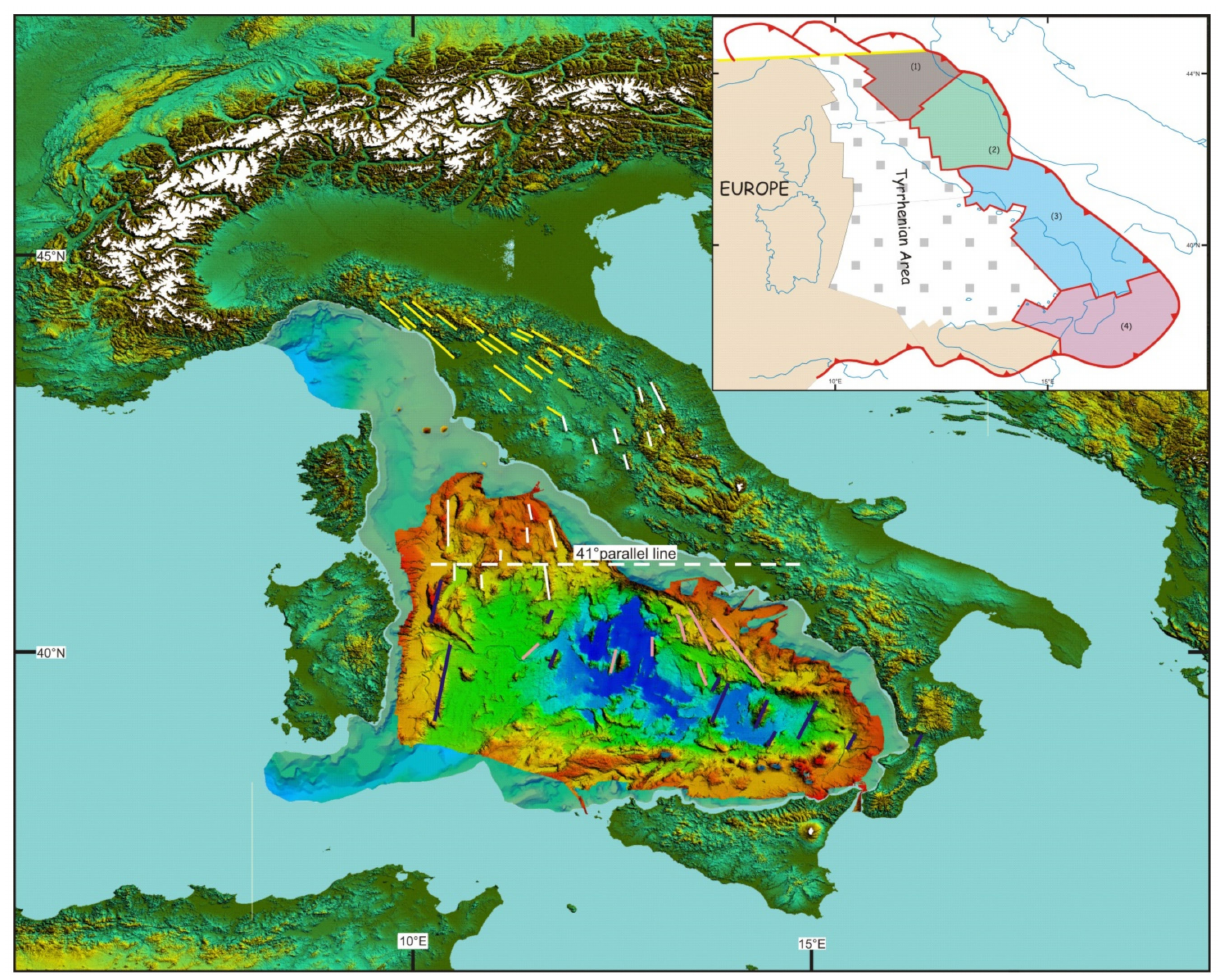
Figure 9. Morpho-tectonic map of the Tyrrhenian–Apennine system showing lineaments that can be grouped into fan- shaped sets characterizing specific sectors. Lineaments of the Northern Apennine sector are in ( yellow ; white lines ) are for northern Tyrrhenian basin and Central Apennine sector; ( blue and pink lines ) are for Calabrian and Southern sectors respectively. The multibeam bathymetry is after [63]. The insert box shows the deformable blocks identified: (1) Northern sector in ( dark beige ), (2) Central Sector in ( green ), (3) southern sector in ( blue ); (4) Calabrian Arc Sector in ( pink ). Dotted areas are in extension; ( white dotted ) area is the extended Tyrrhenian